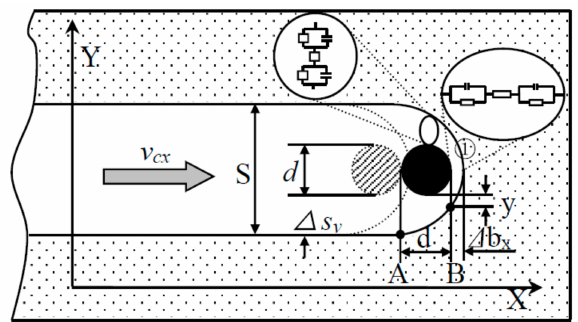
Figure 3. Sketch of feeding along XY